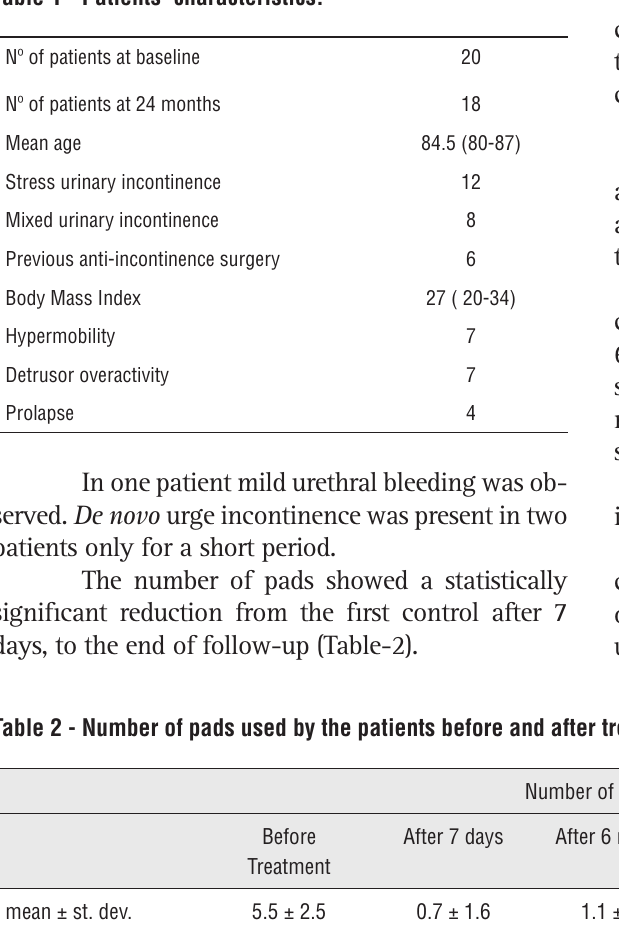
Table 1 - Patients’ characteristics.